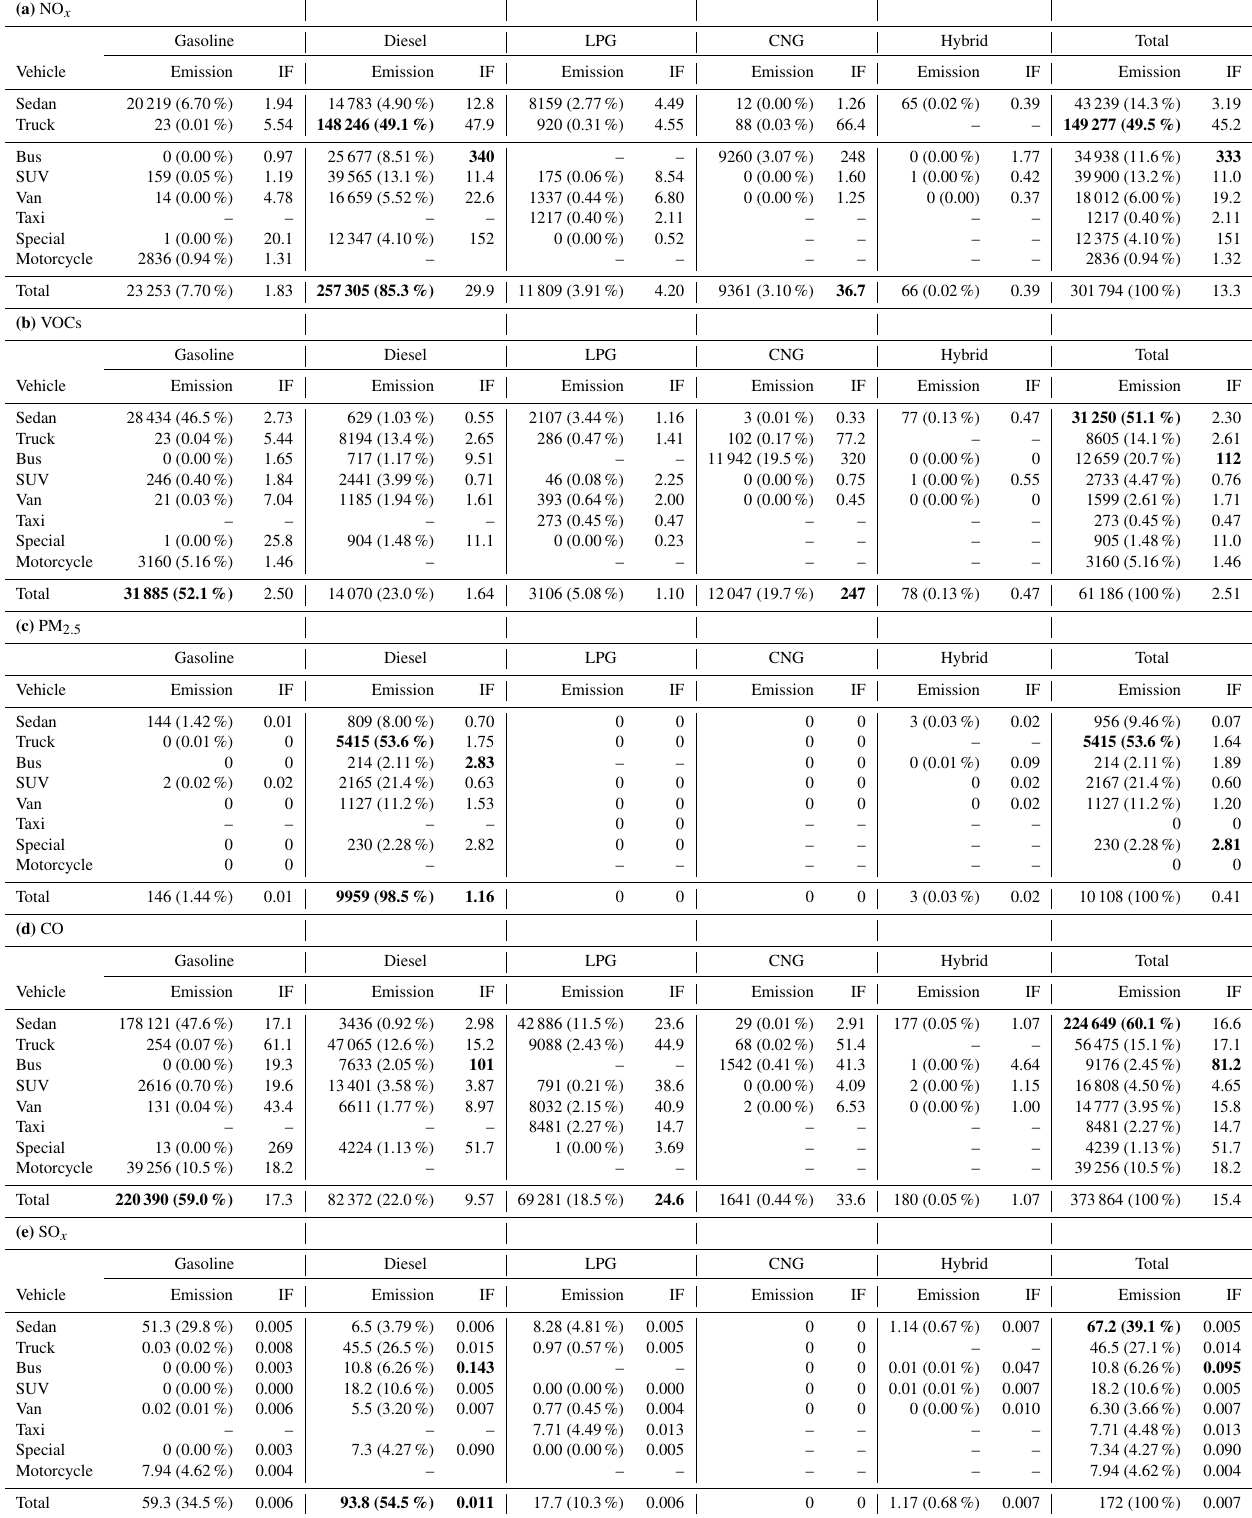
Table 3. Summary table of emissions (tyr − 1 ), contributions (%) and impact factors (IFs, kgyr − 1 ) per vehicle for criteria air pollutants (CAPs) by vehicle and fuel type (a) for NO x , (b) VOCs, (c) PM 2 . 5 , (d) CO, (e) SO x , and (f) NH 3 . The bold font indicates the major contributors to vehicle type and fuel